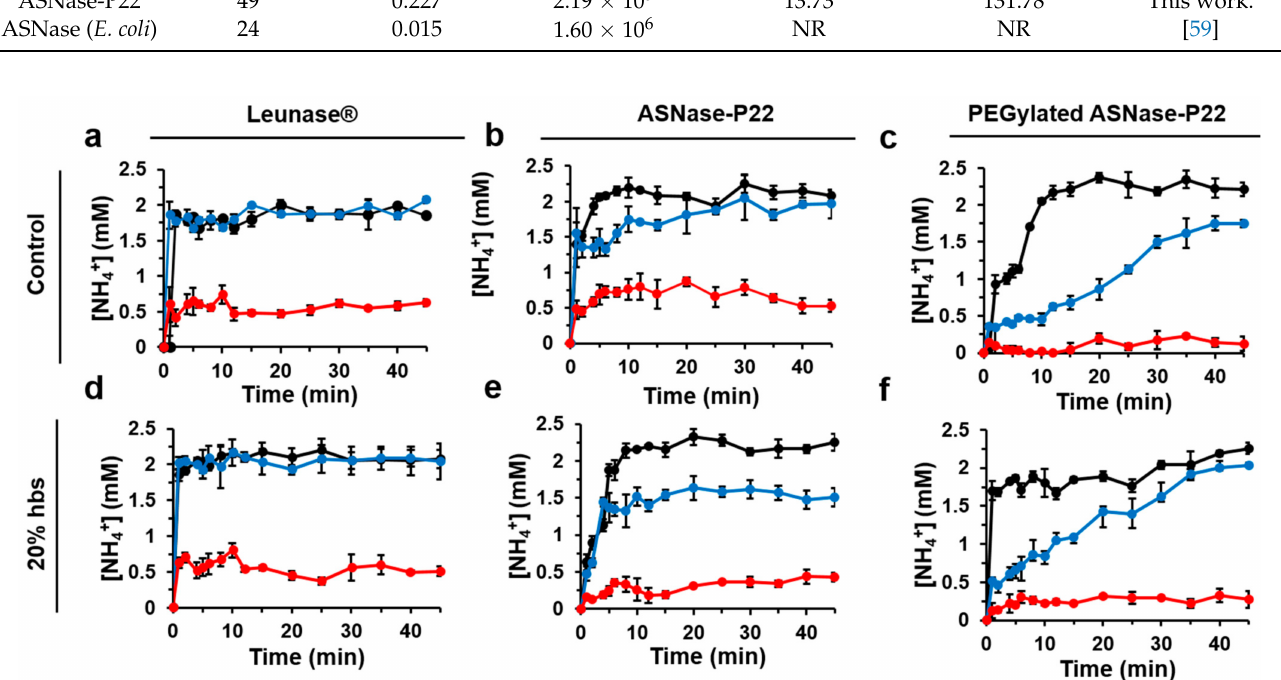
Table 3. Kinetic parameters of ASNase-P22 nanoreactors compared to the native ASNase of E. coli . Sample